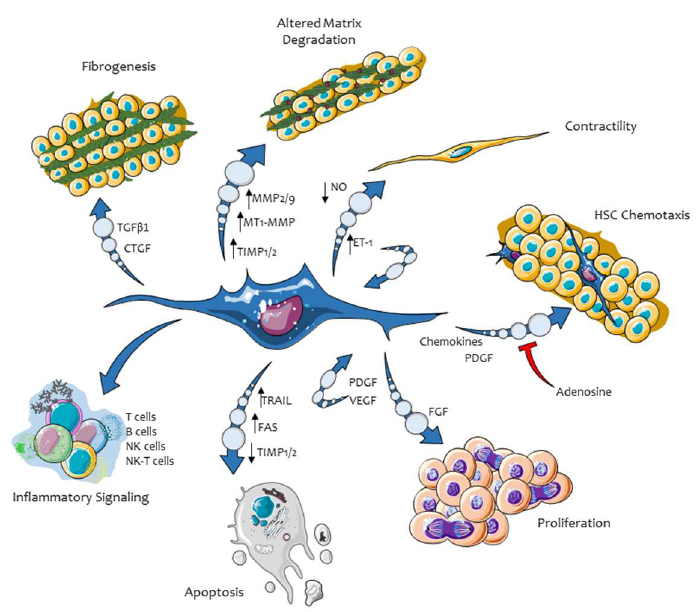
Figure 3. Major phenotypic responses in activated, myofibroblast-like cells (HSC/MFs) as well as, more generally, in hepatic MFs.